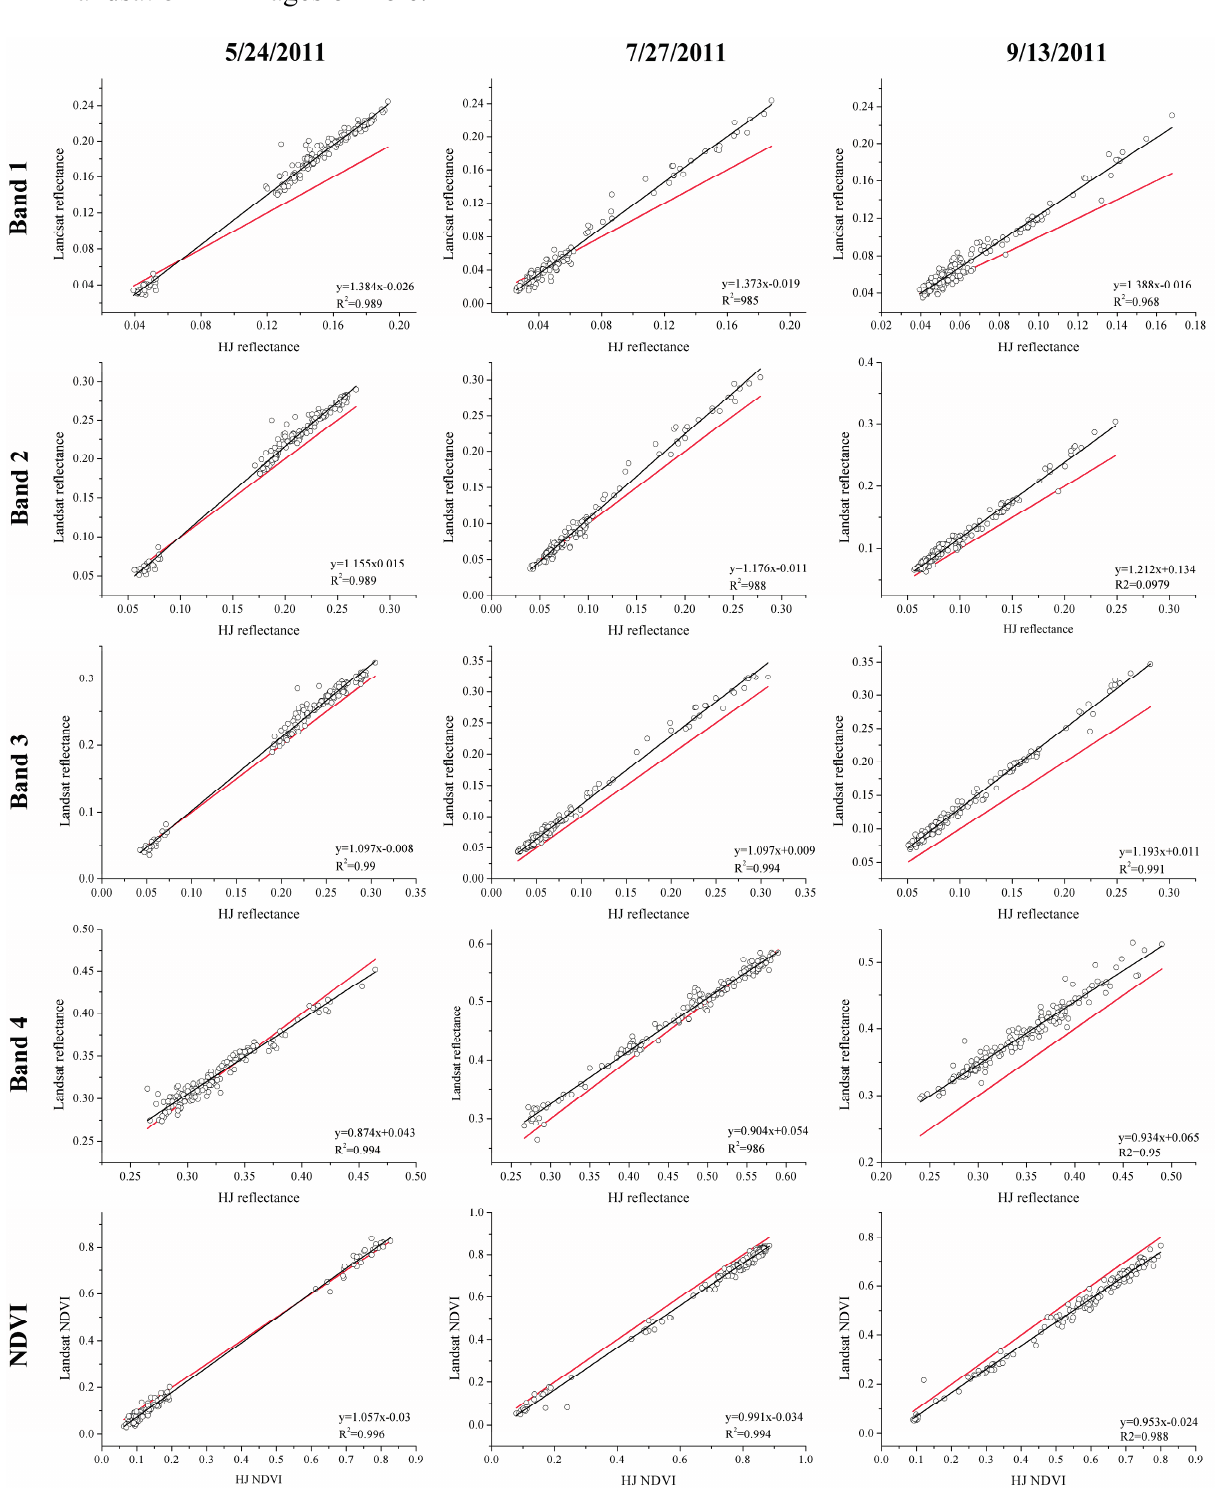
Figure 4. Scatter plots of the land surface reflectance and NDVI data from HJ-1 CCD and Landsat-5 TM images of